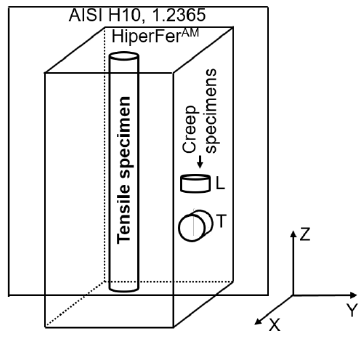
Figure 1. Schematic representation of electrical discharge machining of mechanical testing speci- mens from HiperFer AM LMD samples: creep specimens were taken from both the longitudinal and transversal directions, while tensile specimens were taken from the longitudinal direction only.